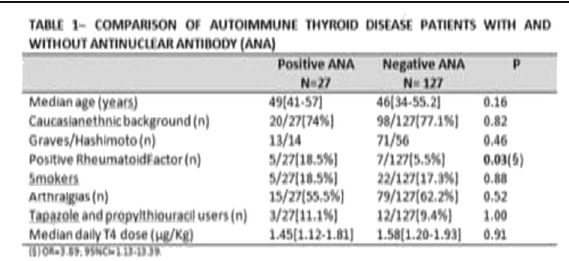
Table 1 (abstract P393). COMPARISON OF AUTOIMMUNE THYROID DISEASE PATIENTS WITH AND WITHOUT ANTINUCLEAR ANTIBODY